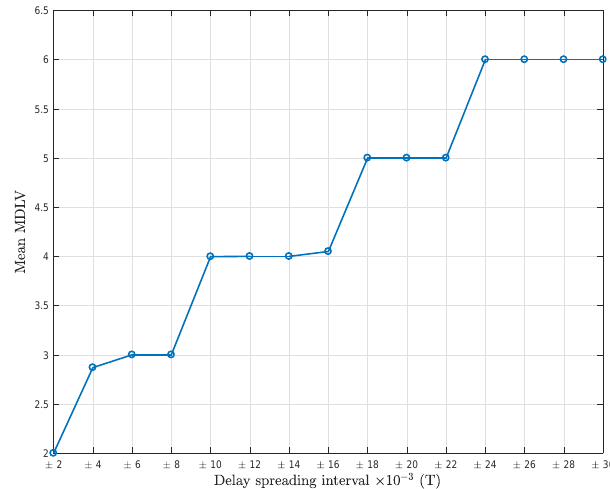
Figure 6. Mean MDLV vs. delay spreading; P l = 20, K = 64, SNR = 15